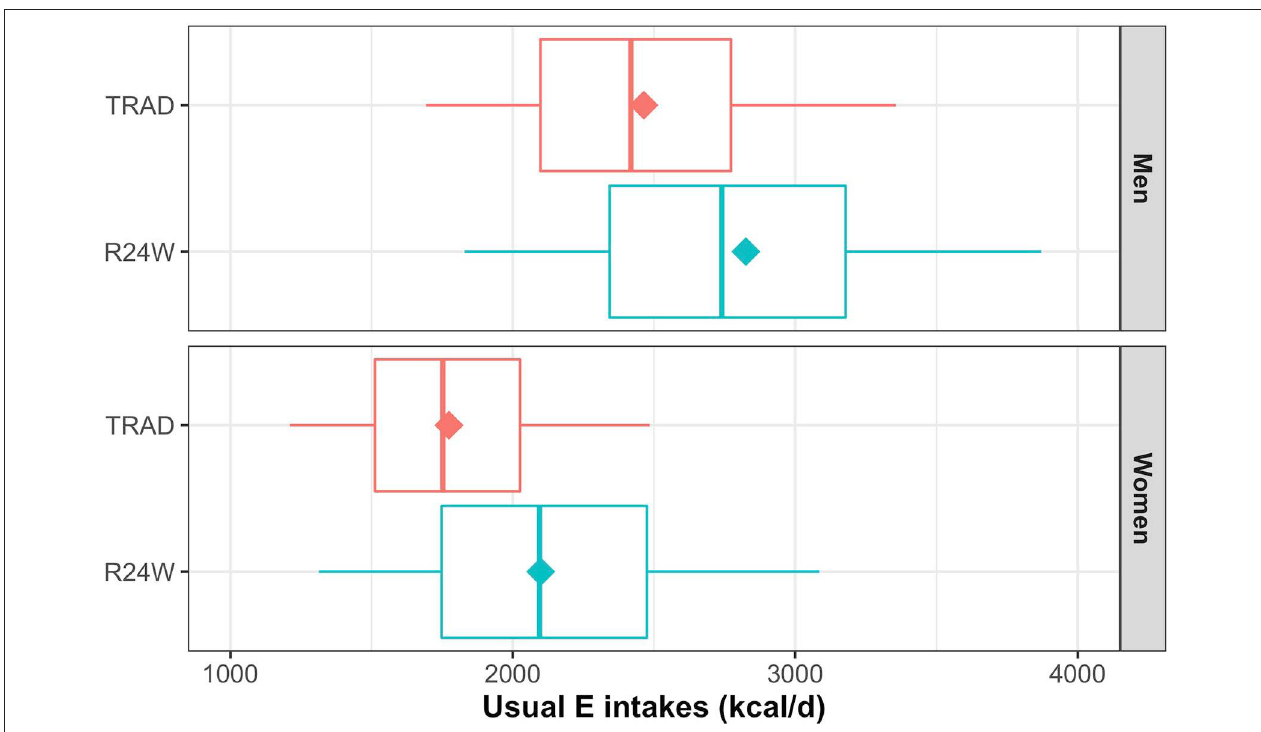
FIGURE 3 | Box-and-whisker plot for self-reported energy intakes by dietary assessment instrument and sex. The NCI methods 2.1 (amount model) were used to compute usual intakes distribution. Boxes represent quantiles 0.25, 0.50, and 0.75. Lower and upper whiskers are respectively quantiles 0.05 and 0.95. Diamonds are mean. Data were adjusted for age, sex, administrative region, education level, body mass index, weekend, and season through the sample balancing process using sex-specific sampling weights. E,